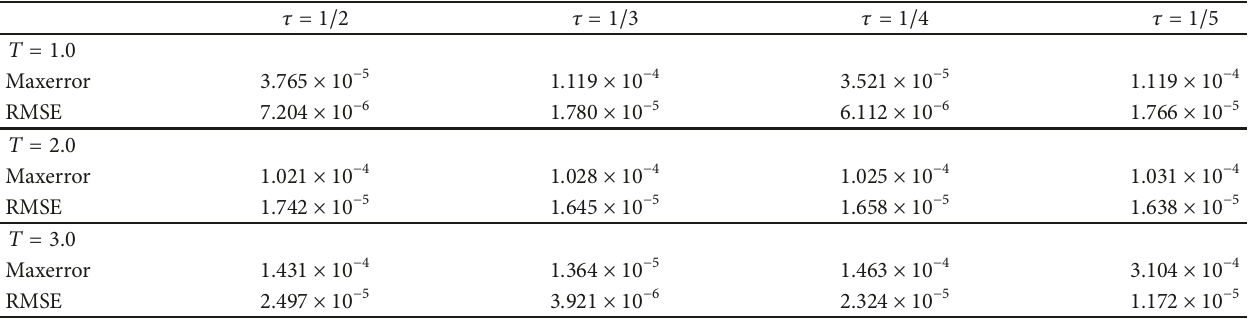
Table 6: Maxerror and RMSE for 𝑇 = 1,2, 3 with different 𝜏